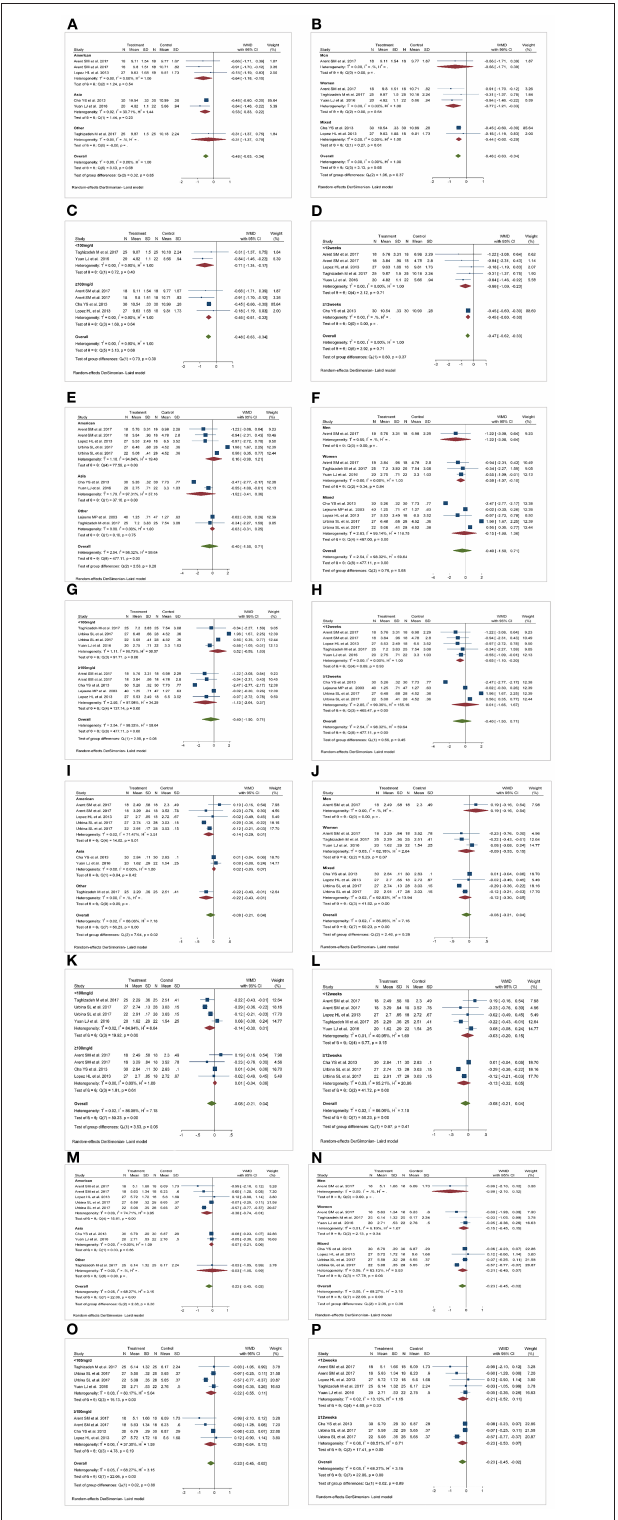
FIGURE 5 | Results of subgroup analysis. (A,E,I,M) Effect of capsaicin (CAP) on total cholesterol (TC), triglycerides (TG), high-density lipoprotein cholesterol